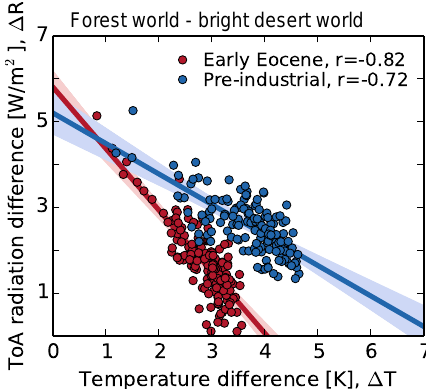
Figure 4. Evolution of differences in the TOA radiative flux be- tween the forest world and the bright desert world with corre- sponding differences in near-surface temperature. Global annual- mean values are considered. Red and blue points relate to the early Eocene climate and to the pre-industrial climate, respectively. The first 150 years are shown and considered for the regression and the correlation coefficient, r . The shaded areas refer to the 95% confi- dence interval for the regression